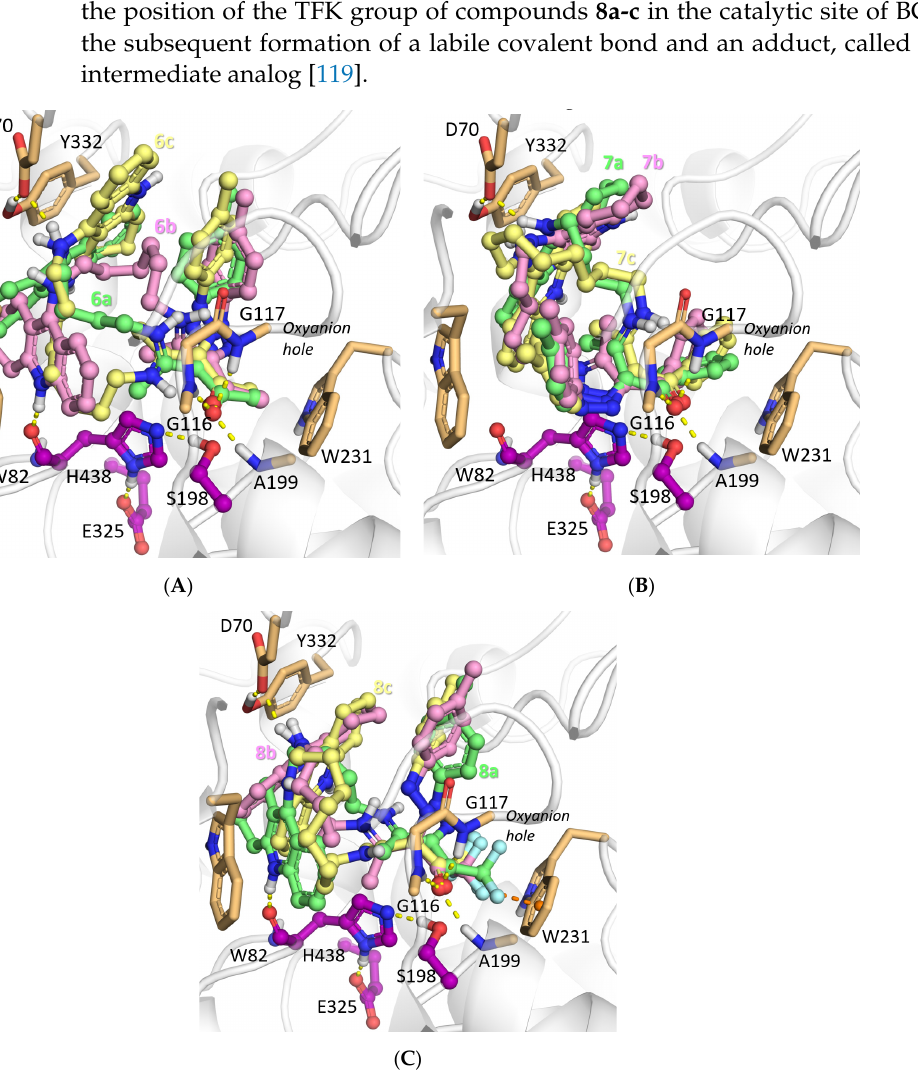
Figure 5. Molecular docking to the active site of BChE of conjugates 6a–c ( A ), 7a–c ( B ), and 8a–c ( C ). Carbon atoms of compounds 6–8a are colored green, 6–8b —pink, 6–8c —yellow.